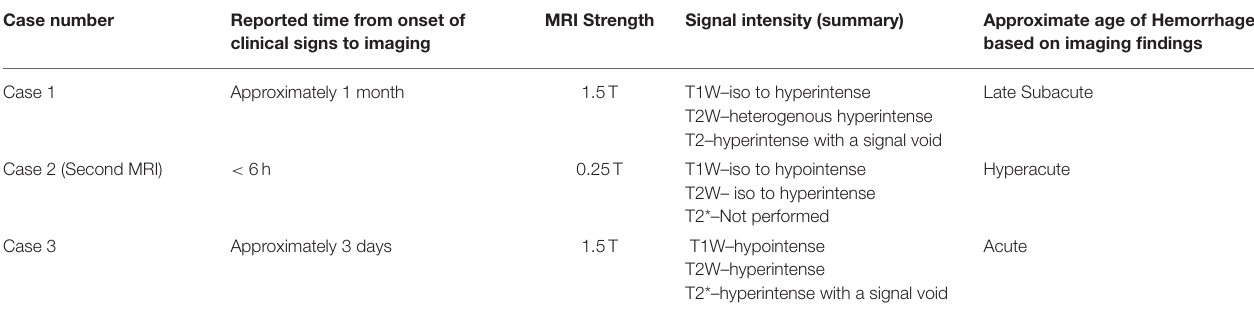
TABLE 1 | Timeline and MRI characteristics of cases 1, 2 (second MRI), and 3 with the corresponding estimated age of hemorrhage. Case number Reported time from onset of MRI clinical signs to imaging